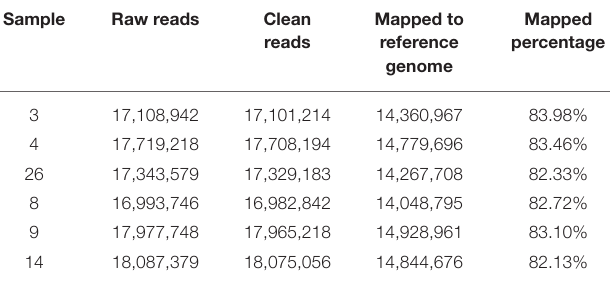
TABLE 1 | Summary of reads generated by MeDIP-seq for per